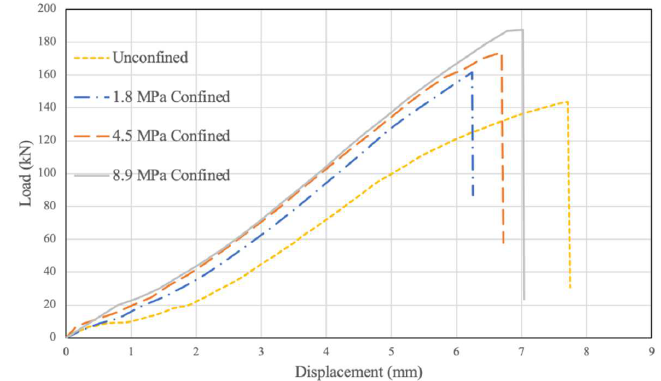
Figure 11. Combined Load vs. Displacement Results Under Various Levels of Confinement.